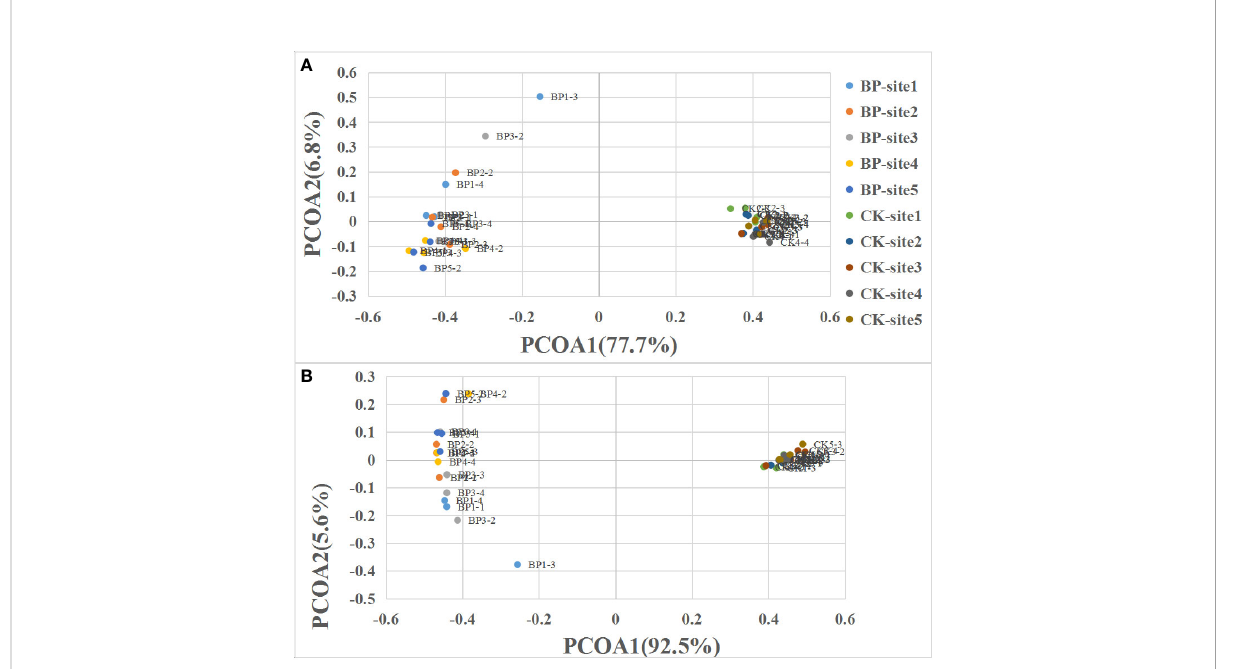
FIGURE 2 Principal coordinates analysis (PCoA) of (A) the plant community and (B) the graminoid community. Graminoids included grasses and